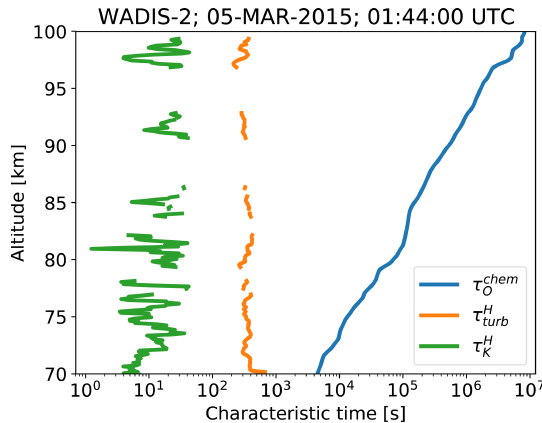
Figure 15. Characteristic timescales derived from in situ measure- ments. τ chem – chemical lifetime of atomic oxygen, τ H – charac- O turb teristic timescale for the largest turbulent eddies derived based on the Heisenberg model, τ H – Kolmogorov timescale derived based K on the Heisenberg